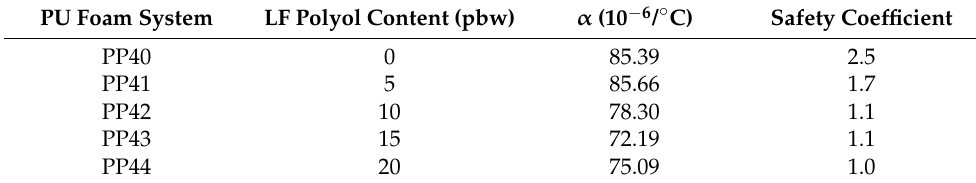
Table 7. Linear thermal expansion and safety coefficient of developed rigid PUR foams. PU Foam